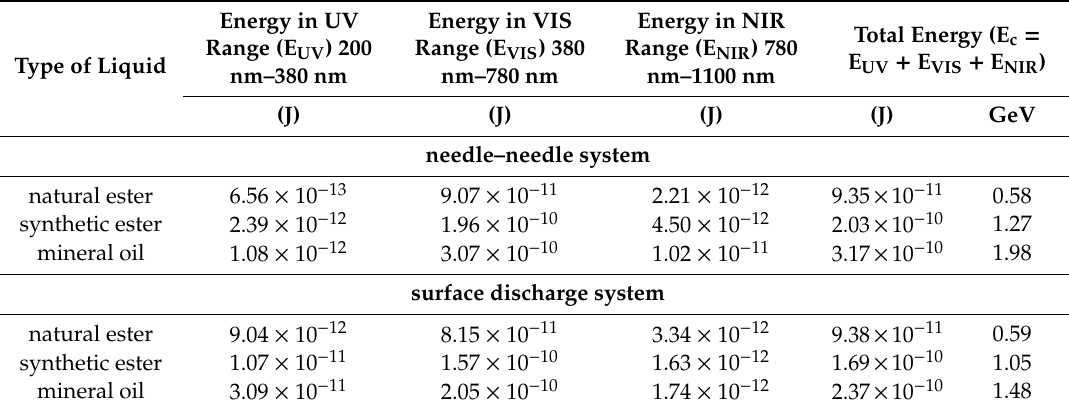
Table 2. Examples of optical radiation energy values.